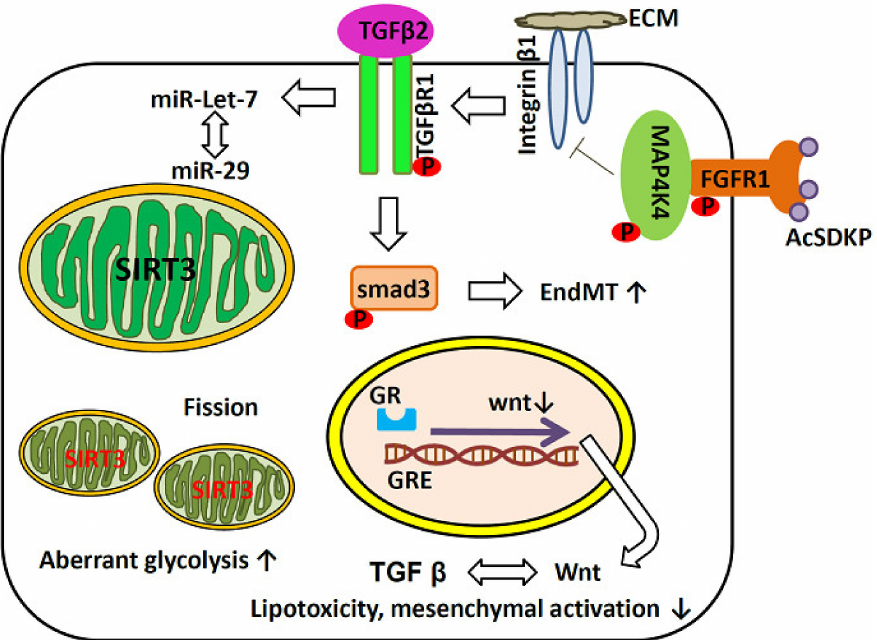
Figure 2. Endothelial cell dysfunction in renal fibrosis. AcSDKP: N-acetyl-seryl-aspartyl-proline; ECM: extracellular matrix; EndMT: endothelial-to-mesenchymal transition; FGFR: fibroblast growth factor receptor; GR: glucocorticoid receptor; GRE: glucocorticoid response element; TGF- β : transform- ing growth factor- β ; MAP4K4: mitogen-activated protein kinase kinase kinase kinase 4. Red SIRT3 indicates deficiency and black SIRT3 indicates sufficiency. ↑ : Increase in the expression level; ↓ : Decrease in the expression